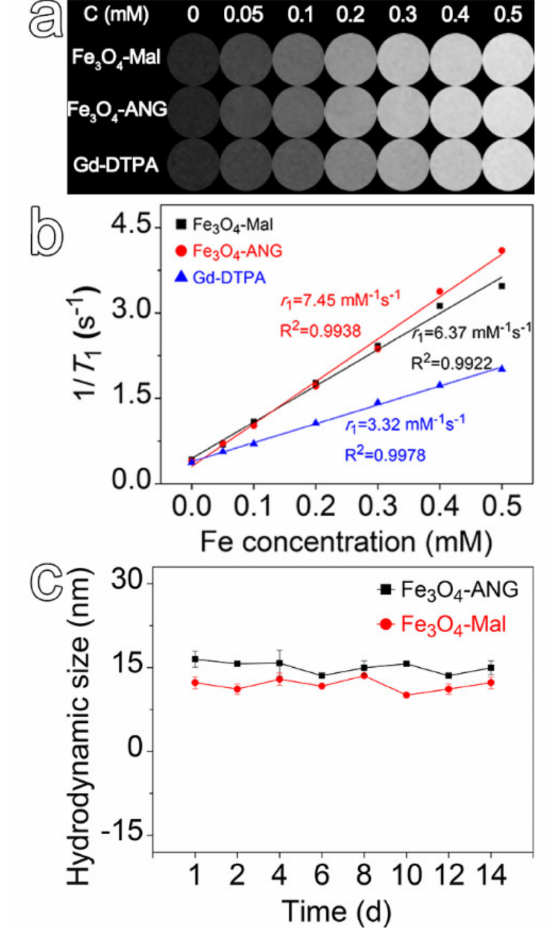
Figure 2. ( a ) T 1 -weighted images of the Fe 3 O 4 -Mal, Fe 3 O 4 -ANG NPs, and Gd-DTPA. ( b ) Linear regression fitting of the relaxivity of Fe 3 O 4 -Mal, Fe 3 O 4 -ANG NPs, and Gd-DTPA for extracting the longitudinal relaxivity r 1 . ( c ) Stability evaluation for Fe 3 O 4 -Mal and Fe 3 O 4 -ANG NPs incubated in PBS for 14